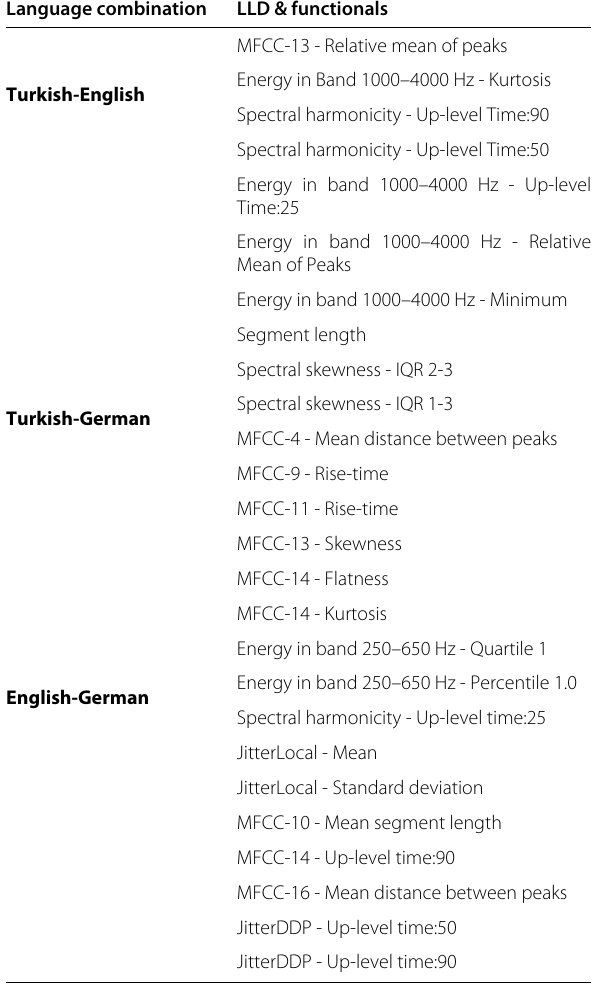
Table 12 Overlapping features in language pairs that are in the top 150 MRMR-selected features Language combination